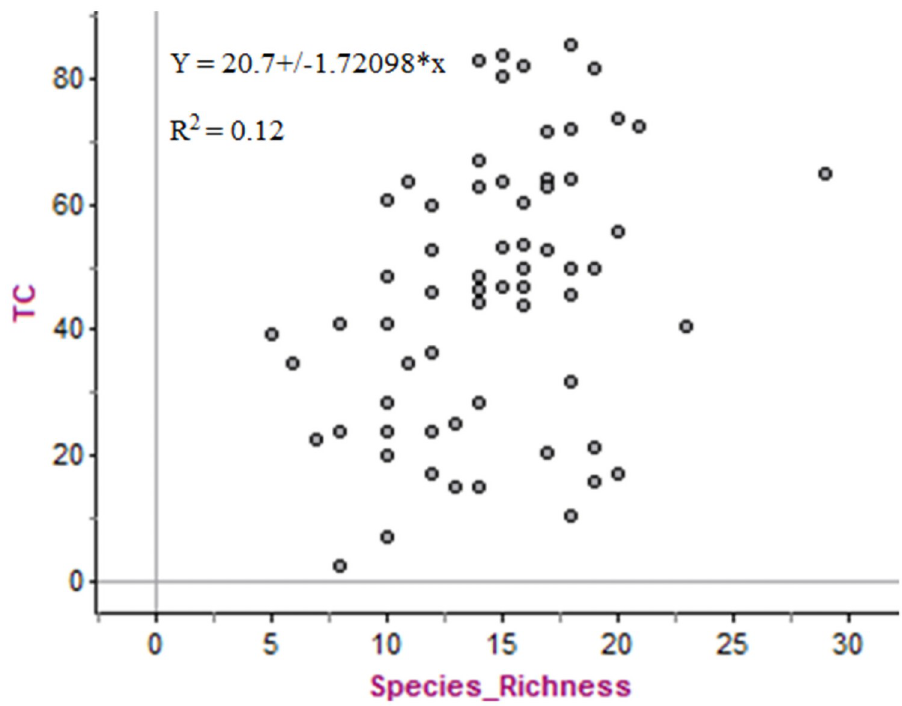
Fig 3. Scatter plot showing the correlation between TC stocks and species richness in Kibate